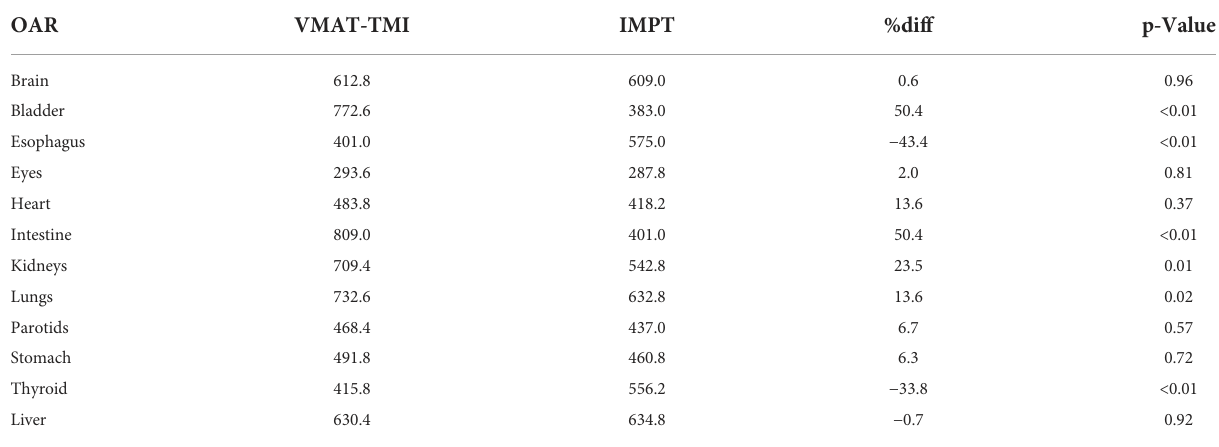
TABLE 3 Mean OAR doses and percentage differences between the VMAT and IMPT